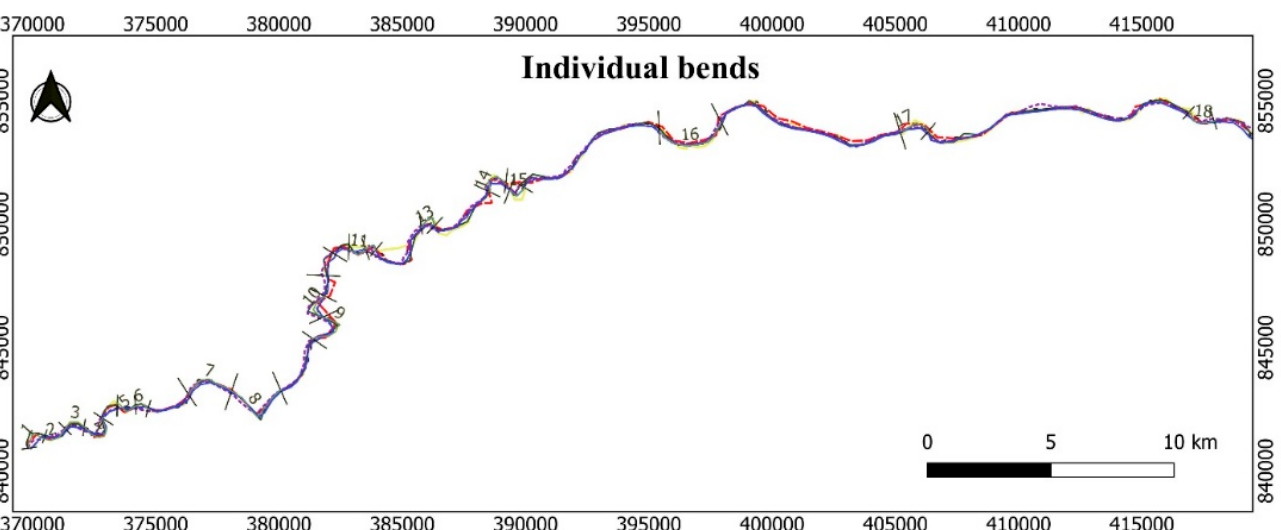
Figure 9. Separation of individual meander bends along the Deduru Oya.